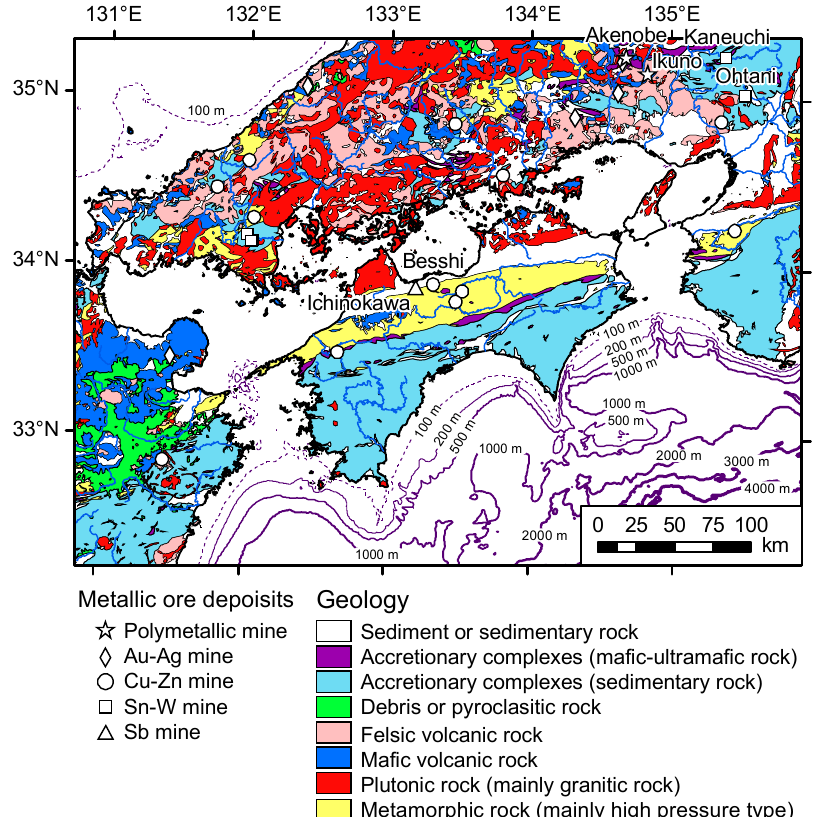
Figure 2. Geological map of the study area simplified from the Geological Map of Japan 1:1,000,000 [17].